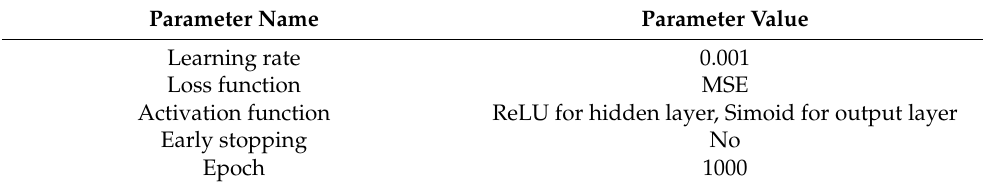
Table 3. ANN configuration and parameters used to train ANN